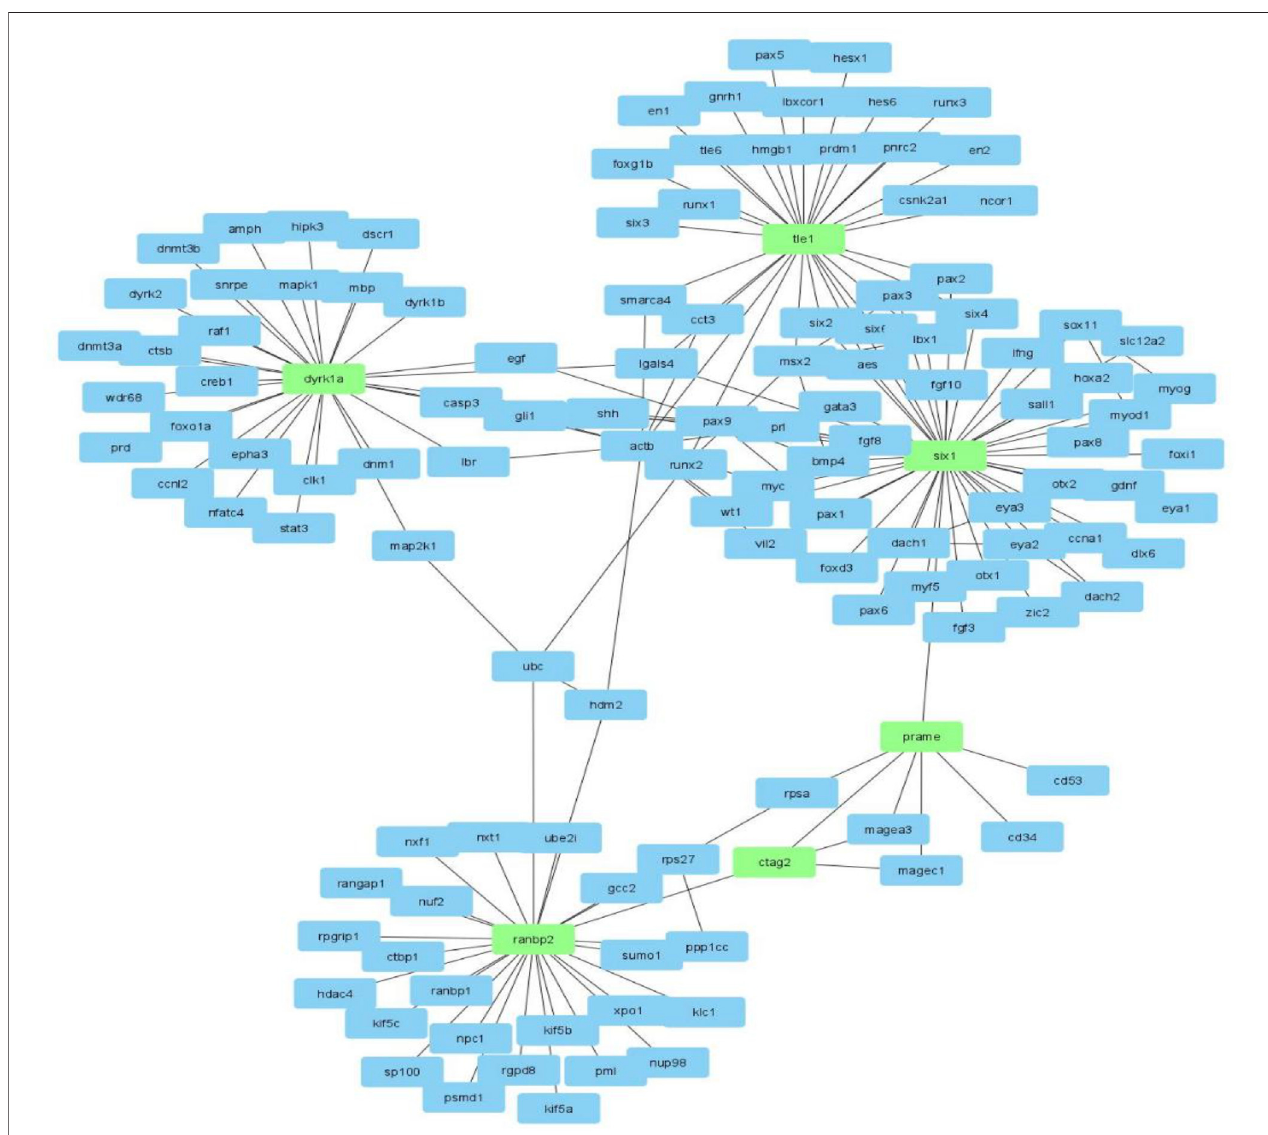
FIGURE 5 | The ctag1b/a ( ctag2 ) network neighborhood rearranged with Cytoscape in order to reveal the links and neighborhoods between ctag1b/a , ranbp2 , prame , six1 , tle1 and dyrk1a .